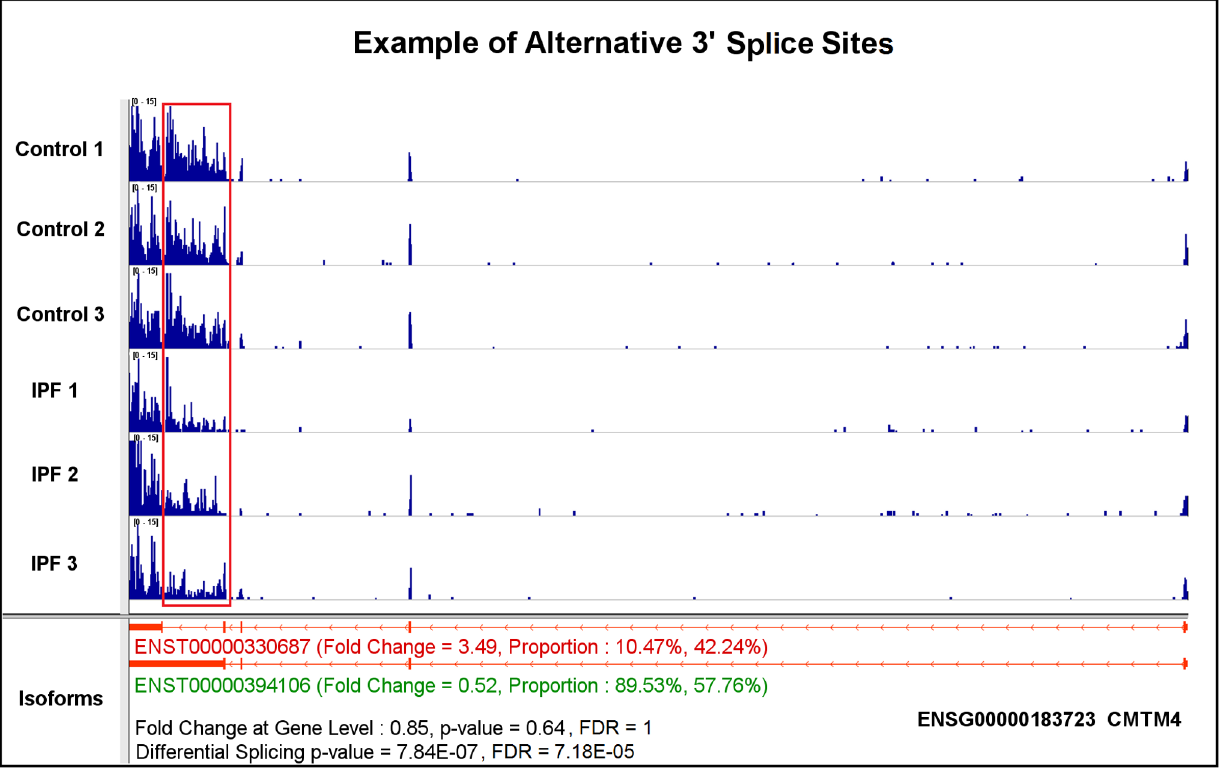
Figure 3. A case study of gene CMTM4 highlighting the alternative 3 9 acceptor site splicing mechanism using the annotated transcripts.